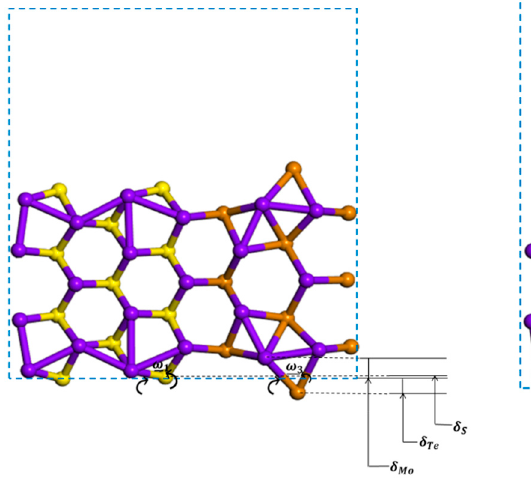
Figure 8. Top and side view of bare armchair (MoS 2 ) 3 /(MoTe 2 ) 3 nanoribbons: ( a ) 7-ac-(MoS 2 ) 3 /(MoTe 2 ) 3 -NR-sym, ( b ) 8-ac- (MoS 2 ) 3 /(MoTe 2 ) 3 -NR-asym. The blue dotted rectangular shows the unit cell of armchair nanoribbon with a vacuum region along the y axis in ( a , b ); ( c , d ) show the bands and dos of bare 7-ac-(MoS 2 ) 3 /(MoTe 2 ) 3 -NR-sym and 8-ac-(MoS 2 ) 3 /(MoTe 2 ) 3 - NR-asym armchair nanoribbon structures.